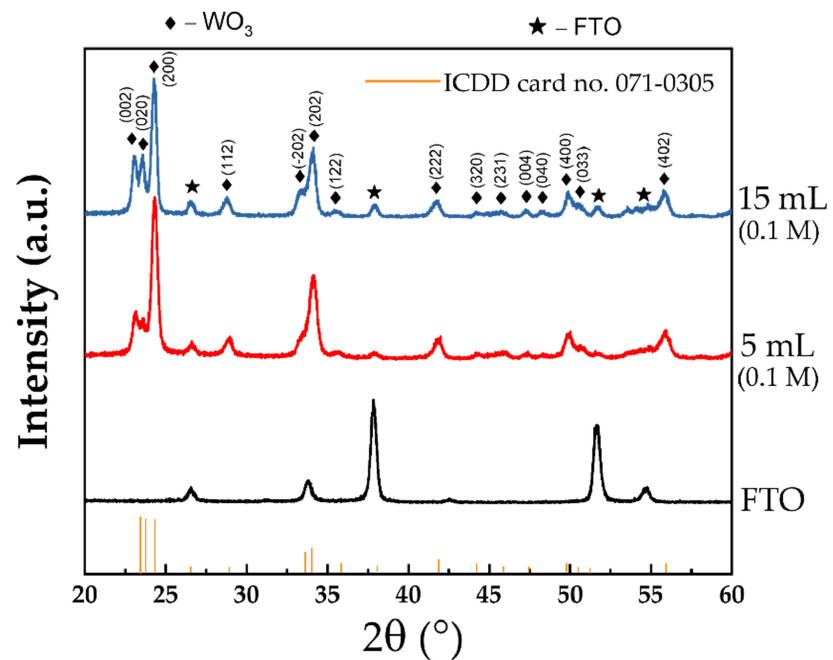
Figure 7. Typical XRD patterns for the WO 3 thin films studied in this work.